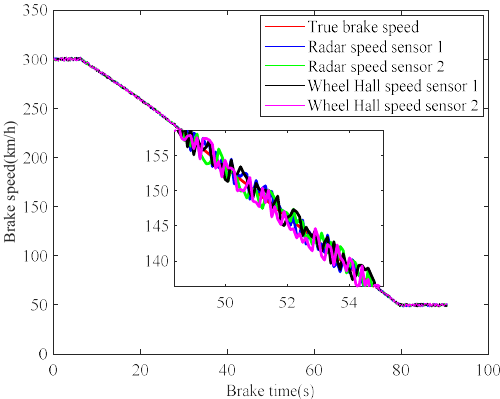
Figure 6. Train braking speed measurements.